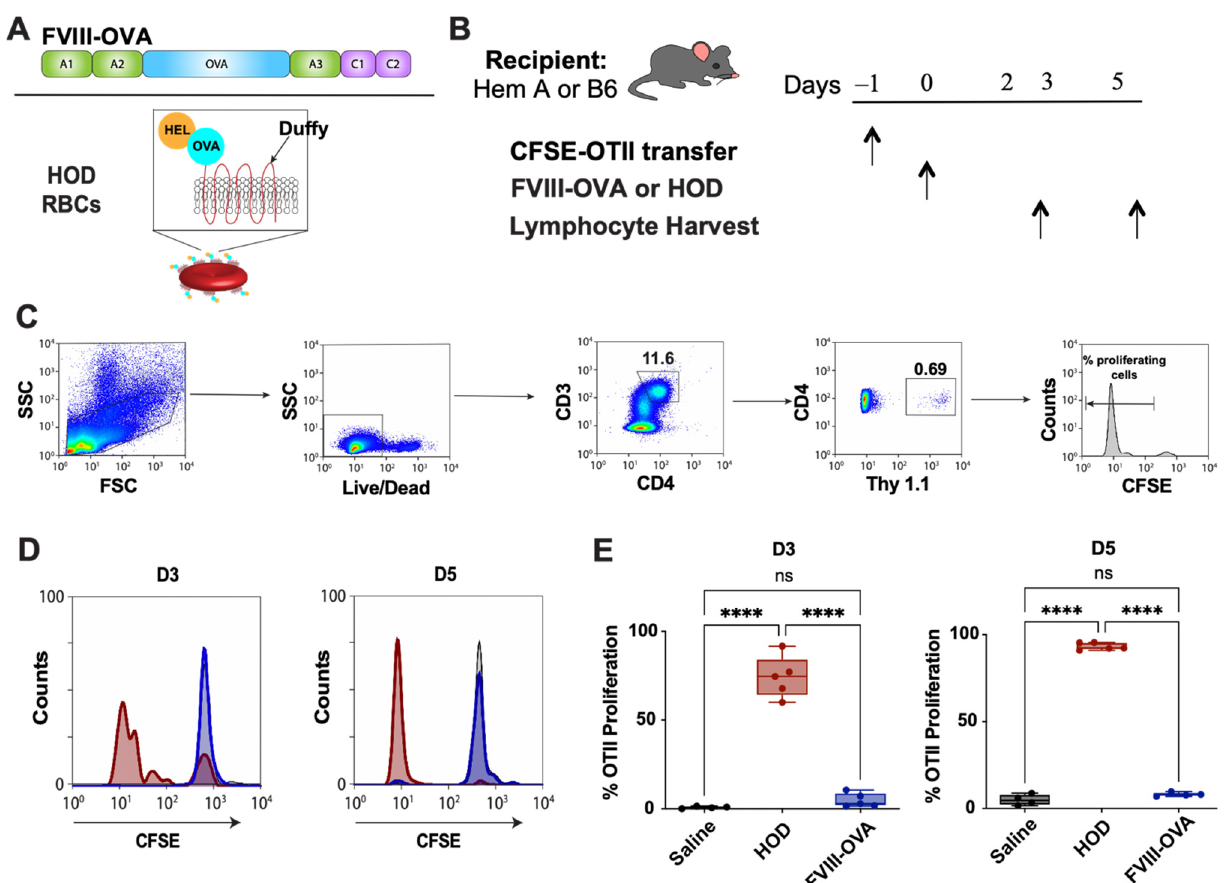
Figure 4. FVIII-OVA does not induce OTII CD4 T cell proliferation in vivo following one exposure. ( A ) Diagrams showing presence of OVA peptide in FVIII (FVIII-OVA) and the HOD (hen egg lysozyme [HEL] and OVA fused with the human RBC antigen Duffy). RBC model system. ( B ) Hemophilia A or B6 mice were adoptively transferred with 10 × 10 6 CFSE-labeled OTII splenocytes, followed by a single infusion of saline, 2 µ g FVIII-OVA or HOD RBCs 24 h later. Lymphocytes were harvested on days 3 and 5 following antigen exposure, and examined by flow cytometry. ( C ) Gating strategy showing assessment of OTII CD4 T cell proliferation. Representative histogram ( D ) and quantification ( E ) of OTII CD4 T cell proliferation in mice treated with saline (black), HOD RBCs (red) or FVIII-OVA (blue). Error bars represent standard deviation, **** = p < 0001; 1-way ANOVA with Tukey’s post hoc test. D3 = day 3; D5 = day 5; ns = not significant.